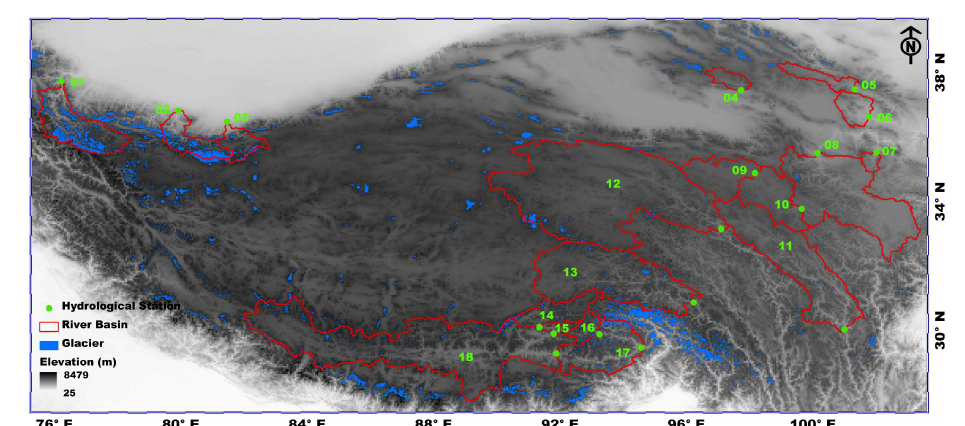
Figure 1. Map of river basins and hydrological gauging stations (green dots) over the Tibetan Plateau (TP) used in this study. The grey shading shows the topography of the TP in metres above sea level, and the blue shading exhibits the glaciers distribution in the TP extracted from the second glacier inventory dataset of